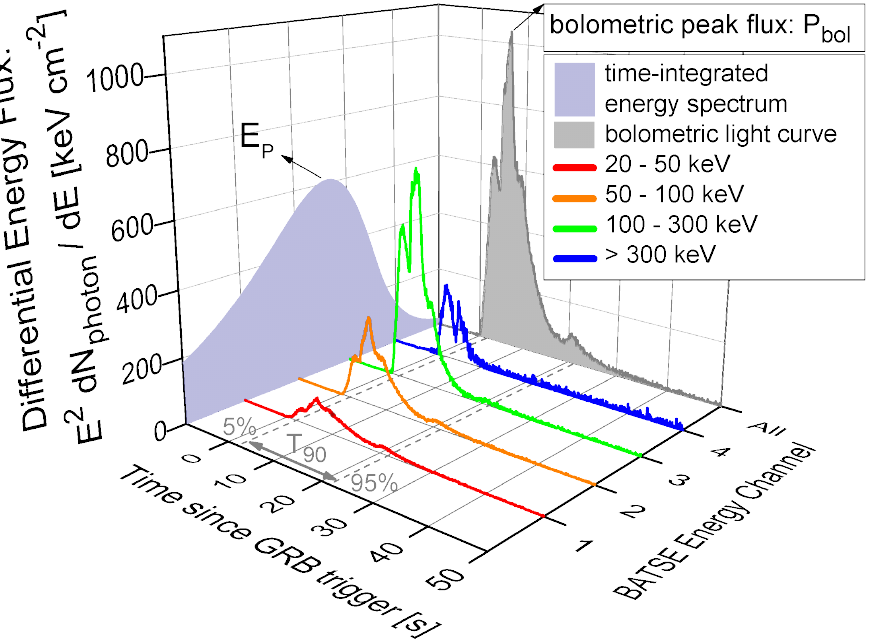
Figure 2. An example time-resolved energy-resolved GRB light-curve illustrating the four main GRB properties that are commonly reported in GRB catalogs and used in this study to infer the missing redshift information of BATSE GRBs. The red, orange, green, and blue colored lines represent the aggregated energy flux received in each energy window as a function of time. The time in which it takes for the GRB to release 90% of its gamma-ray emissions in the observer frame is the T 90 . The violet- and gray-shaded curves represent the time-integrated spectrum and the energy-integrated (bolometric) light-curve of the GRB corresponding to the bolometric fluence S bol of the